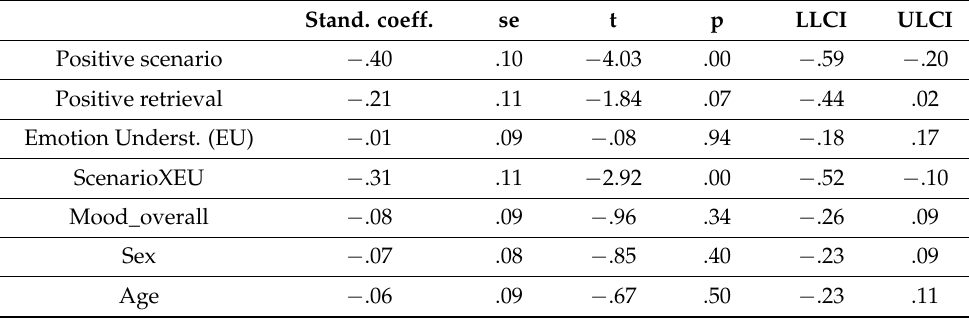
Table 4. Results of the moderated mediation for positive scenario and positive vignette. Outcome variables are: ( a ) positive retrieval, ( b ) impression formation, ( c ) results of the conditional indirect effect. (a) Outcome: positive retrieval (R 2 = .3 2). Stand. coeff. se t p LLCI ULCI Positive scenario .49 .07 6.70 .00 .34 .63 Emotion Underst. (EU) − .15 .08 − 1.90 .06 − .30 .01 ScenarioXEU − .03 .08 − .43 .67 − .18 .12 Mood_overall .05 .08 .67 .50 .21 Sex .04 .64 .18 Age − .01 .08 .87 .14 (b) Outcome: impression formation (R 2 = .3 3). Stand. coeff. se Positive scenario Positive retrieval